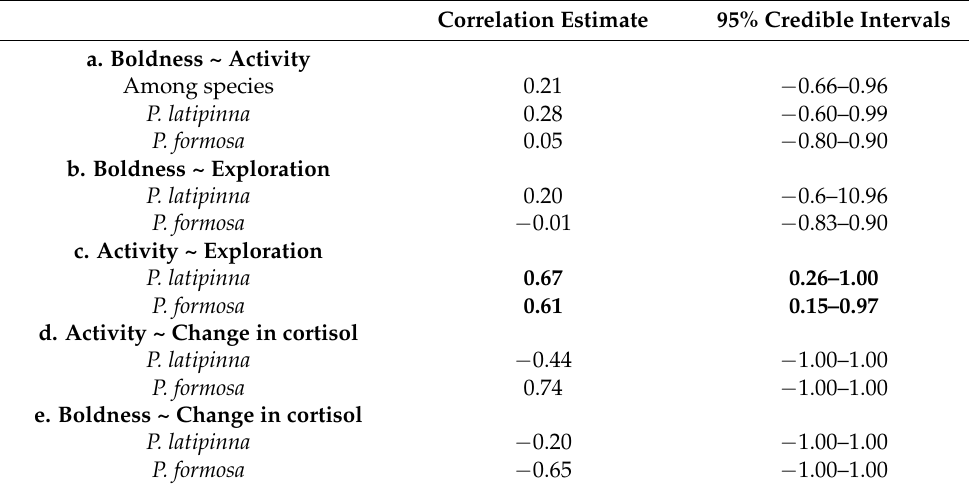
Table 2. Markov chain Monte Carlo multivariate model results for behavior syndromes. Repeated measures of boldness and activity were tested for between and within species syndromes. Non- repeated measures were tested for correlations with boldness and activity for within species syn- dromes. Bold values are